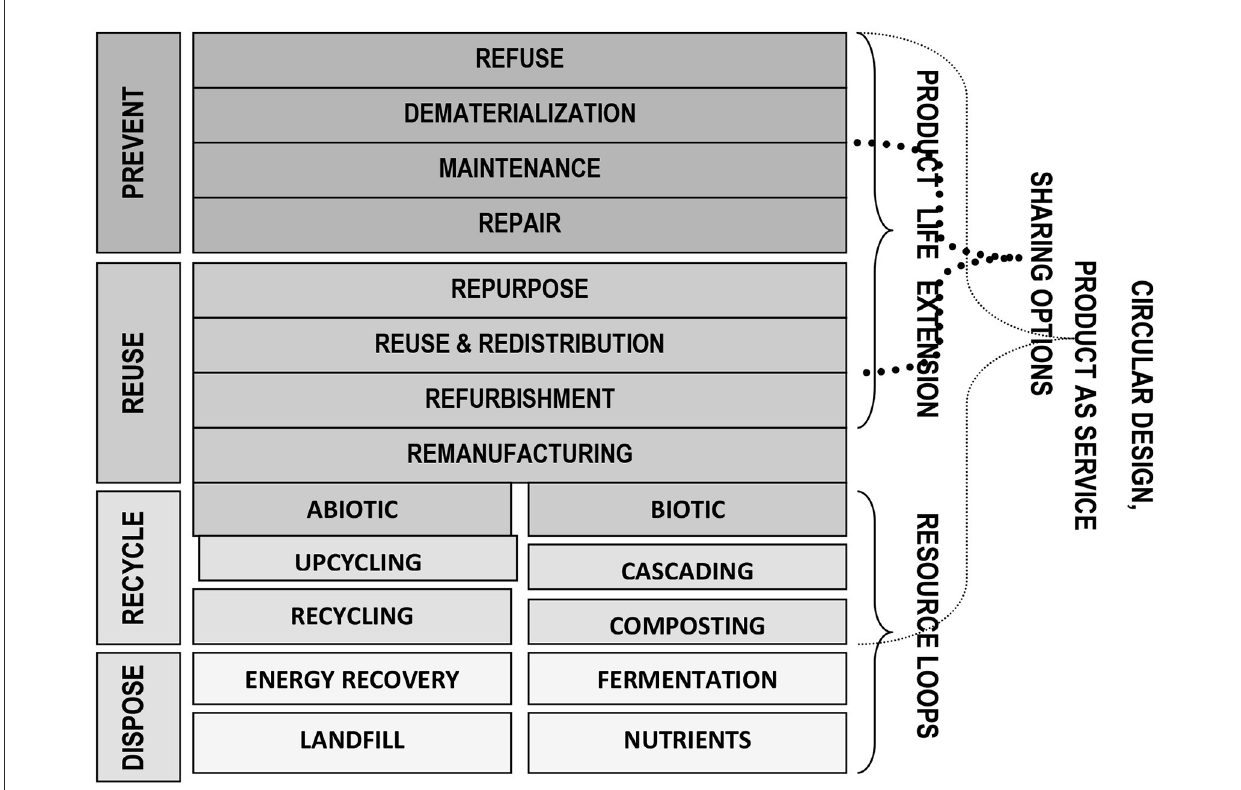
FIGURE5 The circularity ladder. Source: Adapted from De Groene Zaak (2015).